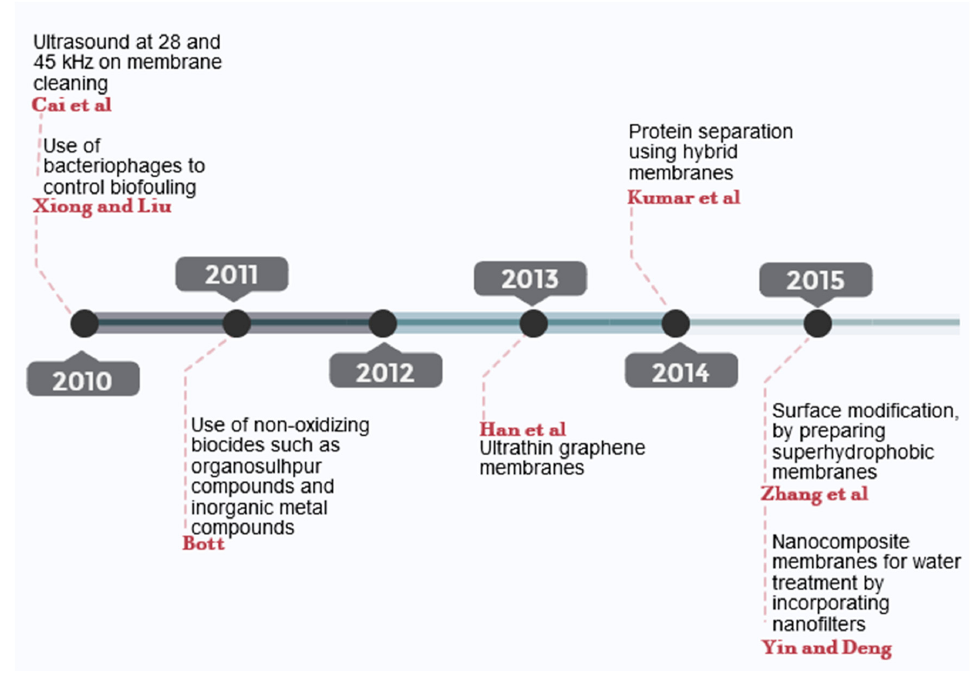
Figure 4. Milestones on the most recent studies on membrane fouling until 2015 [46–50].